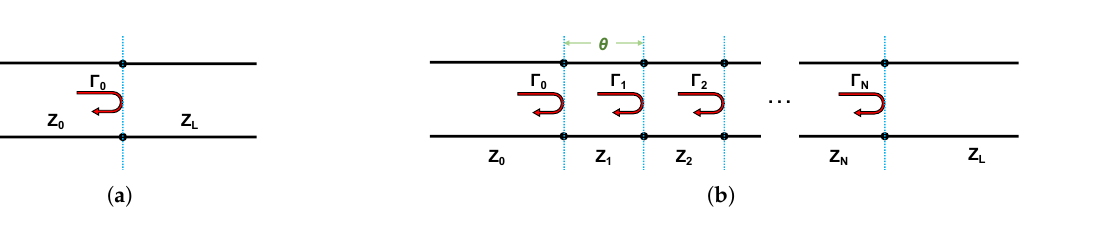
Figure 5. ( a ) Reflection caused by distinct characteristic impedance. ( b ) Multisection transformer from the theory of small